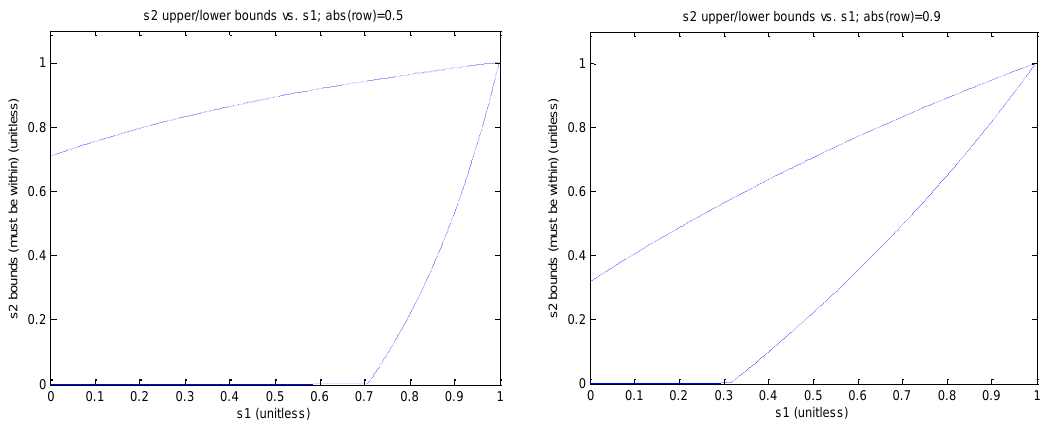
Figure 15. Flow-down of constraints to spatial correlation